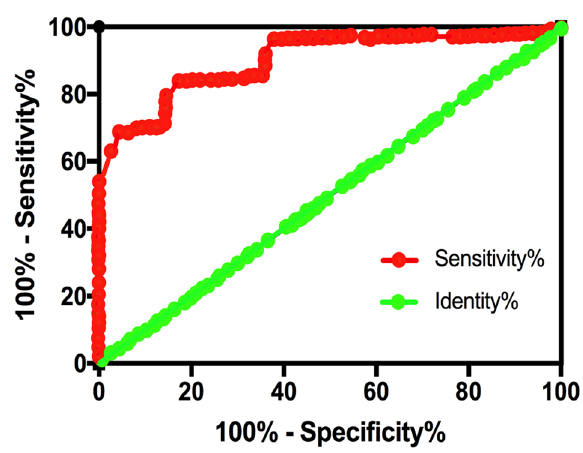
Figure 2. lncRNA FER1L4 downregulation could effectively distinguish OA patients from healthy controls. The diagnostic values of plasma FER1L4 was analyzed using ROC curve.